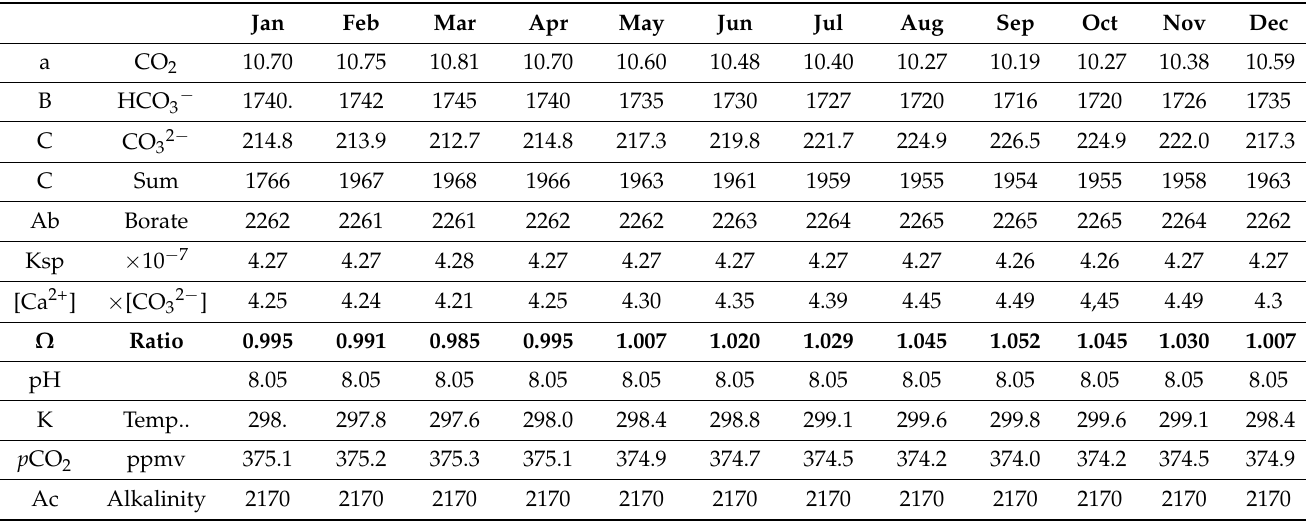
Table 2. Results of numerical modelling (Jan–Dec) showing DIC concentrations for intermediates between CO 2 and calcite varying with changes in regional seawater temperature at constant